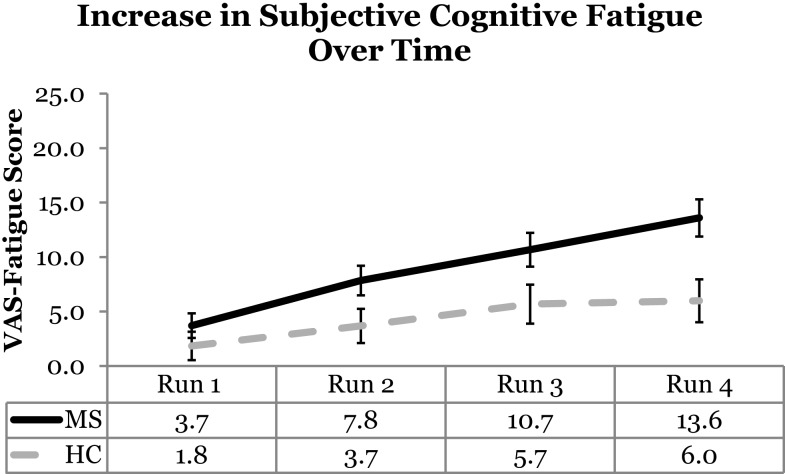
VAS scores as a function of run and group. The MS group showed higher fatigue than the HC group across runs. Error bars represent standard error.